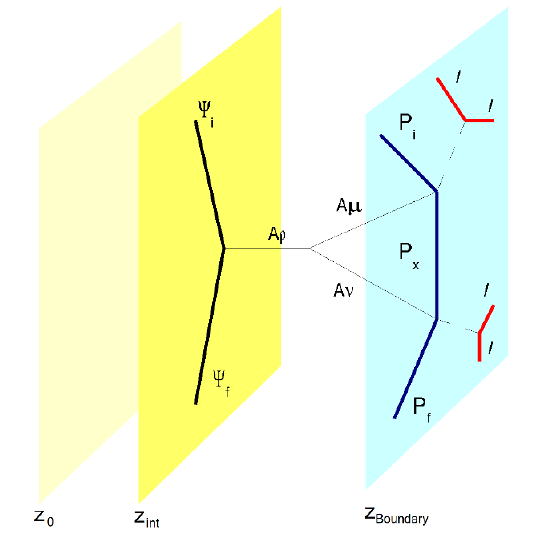
Figure 3. Schematic picture of the t -channel diagram corresponding to the holographic dual p description of forward Compton scattering in the x (cid:28) 1 = (cid:21) regime. The incoming and outgoing spin-1 = 2 hadrons with four-momenta P i and P f are indicated with blue lines in the boundary theory. Their corresponding dual (cid:12)elds in the bulk are denoted by (cid:9) i and (cid:9) f , respectively. Gauge (cid:12)elds A (cid:22) and A (cid:23) couple to the J (cid:22) ( x ) and J (cid:23) (0) electromagnetic currents in the boundary gauge (cid:12)eld